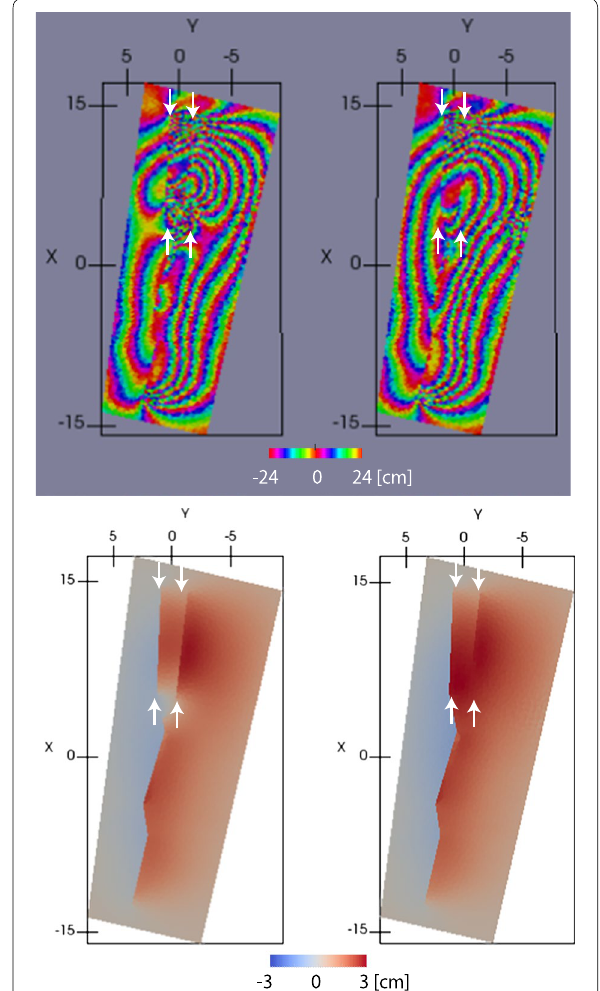
Fig. 11 Spatial distribution of surface displacement for Model S (left) and Model C (right). (Top) The fringes mimic the phases showing the line of the sight distance looking down from the west-northwest (positive X - and Y -axis directions). (Bottom) The vertical displacement. The white arrows mark the ground surface intersections of Faults B1 and